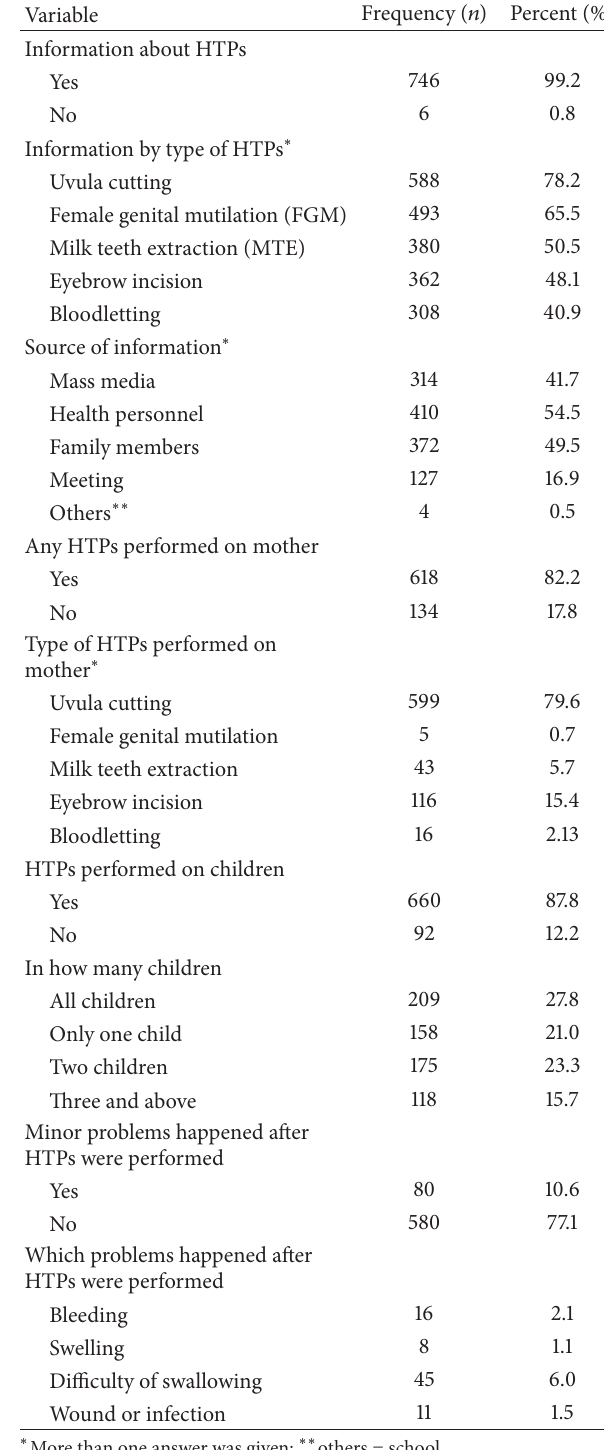
Table 2: Harmful traditional practices among children less than five years old in Axum Town, North Ethiopia,